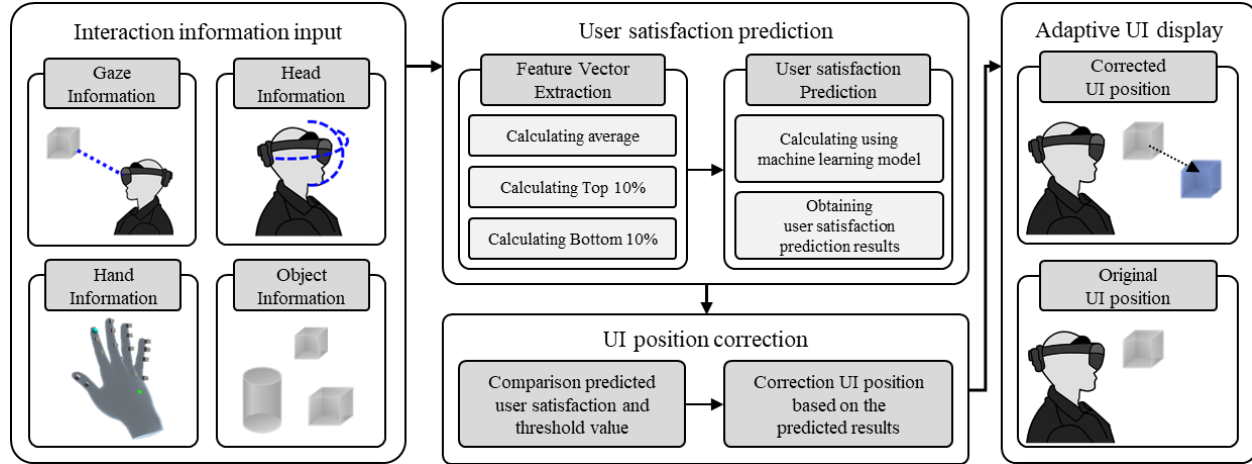
Figure 4. Procedure to provide adaptive UI by the proposed method.